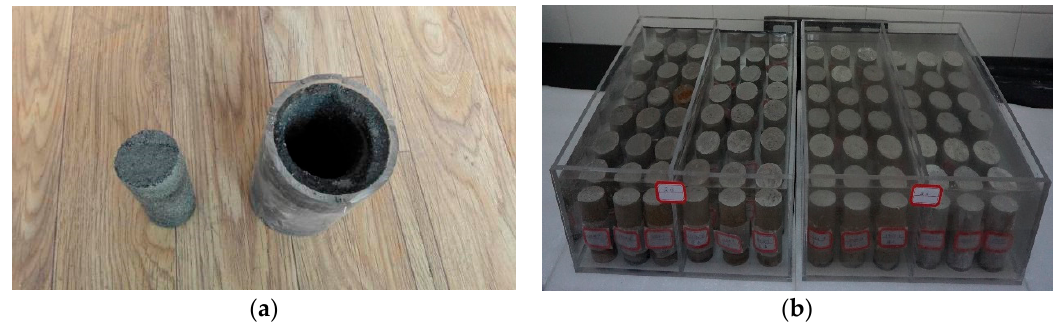
Figure 4. Coring and curing of grouting reinforcement sample. ( a ) Sample core. ( b ) Sample water culture.